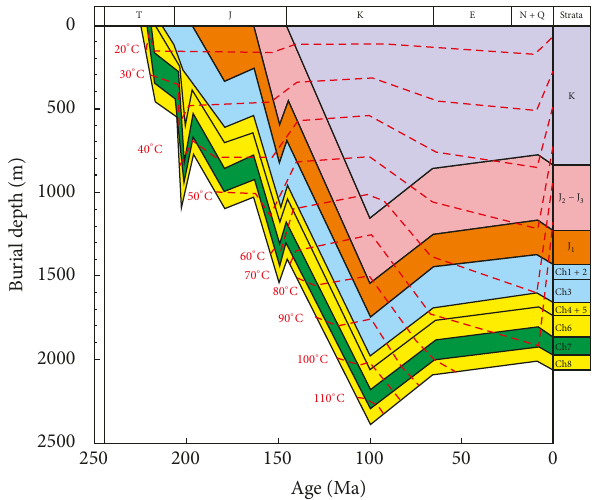
Figure 2: Burial and thermal histories of the Upper Triassic Yanchang Formation for Well L47 in Ordos basin (after